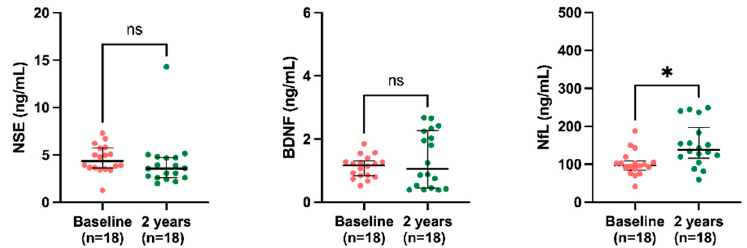
Figure 5. Levels of BBB biomarkers NSE, BDNF, and NfL at the baseline vs. 2 years post-KT among patients with calcification (score 1–3) and fibrosis (score 1–3). Results are presented as the median and IQR. Differences between the baseline and two years post-KT were analyzed using the Wilcoxon paired test. * p < 0.05.